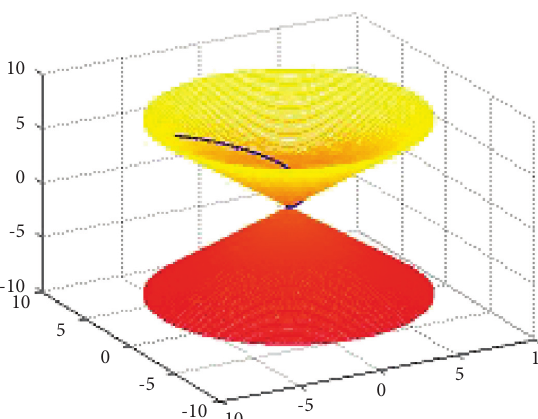
Figure 4: The curve 2 α (blue) lying on the surface 2 M .